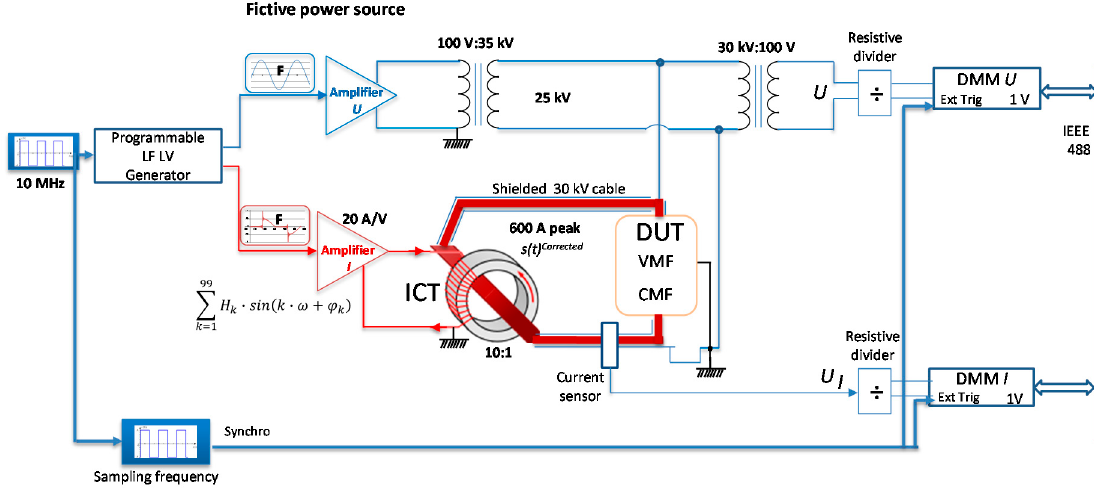
Figure 3. Principle scheme of the LNE current generation and fictive power source.